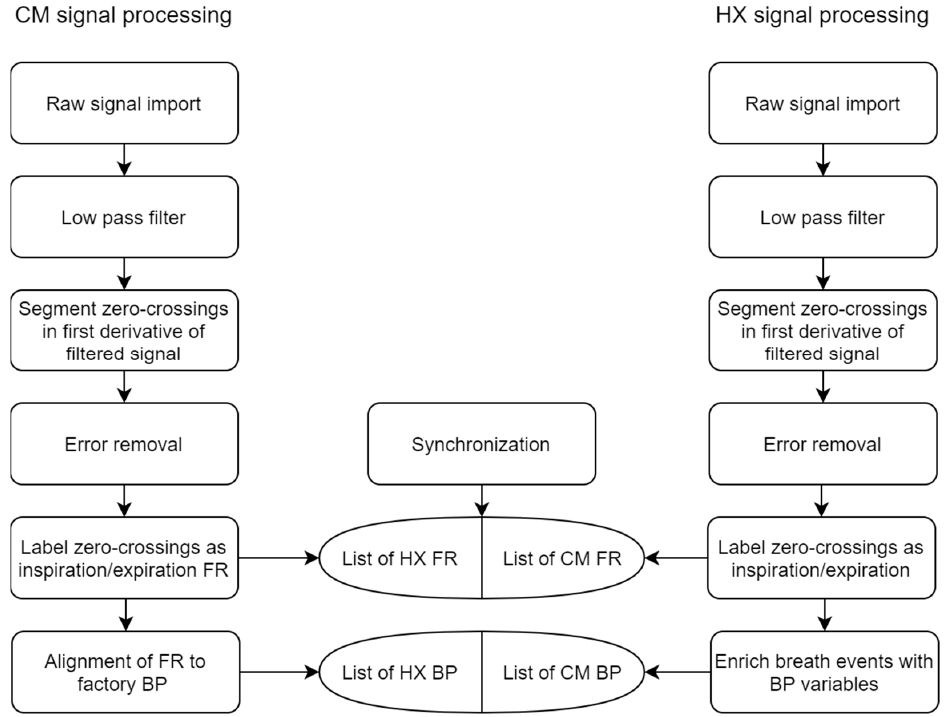
Figure 3. Flowchart of signal and data processing. FR: flow reversal, BP: breathing pattern. Raw HX data were analyzed in a similar routine as above. Signals were filtered with the same procedure as CM; then, zero crossings were detected in the first derivative of the thoracic signal, as each FR occurs near signal peaks and valleys (Figure 4). For error correction, a routine similar to that reported by [12] was implemented; each FR was “scored” via three characteristics: (1) time from last FR, (2) positive or negative slope, and (3) signal magnitude. Then, FR were flagged as “false” if: (1) more than 60% shorter than the average time difference of last five FR or (2) they were first in a short (<0.5 s) double event (same slope sign) (Figure 5). These “false” events were manually checked before elimination. Each FR was labeled as inspiration or expiration according to the signal peaks and valleys, respectively. The list of FR was then used to enrich the dataset with the following features for each breath: time of inhale (tI; time from each peak to valley), time of exhale (tE; time from each valley to peak), tB (sum tI+tE), BR (60/tB), and ds (tI/tB). BR variability (BRV) was calculated using the coefficient of variation (CV) of tB over five breaths [13,14].